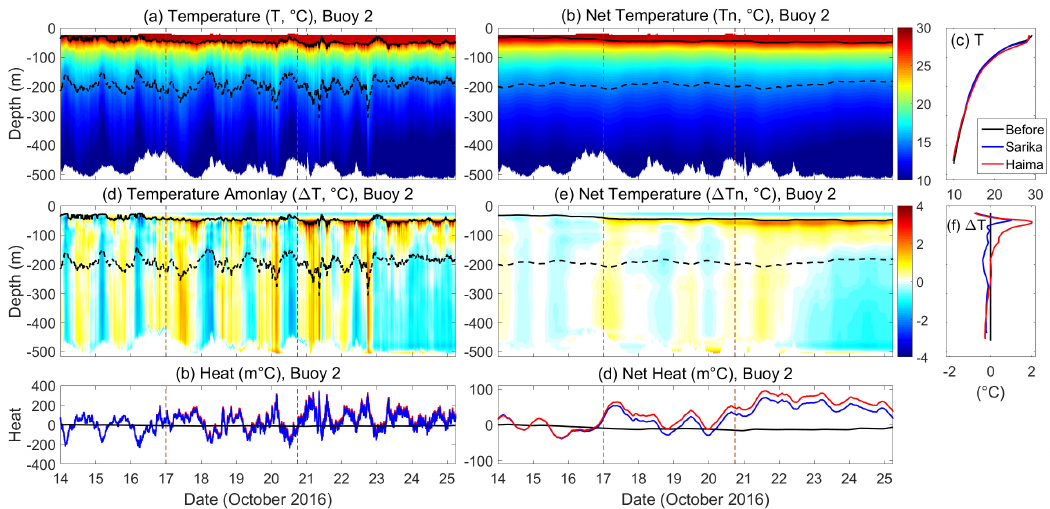
Figure 9. Temperature ( a ), temperature anomaly ( d ) and their net values ( b , e ) during Sarika and Haima at Buoy 2. Average temperature ( c ) and temperature anomaly ( f ) profiles before the two typhoons (black; averaged between 14 and 16 October), after Sarika (blue; averaged over one inertial period after 18 October), and after Haima (red; averaged over one inertial period after 22 October). The black solid lines in ( a , b , d , e ) indicate the mixed layer depth, which is the depth at which the temperature is 0.5 ◦ C lower than the surface layer temperature. The black dashed lines indicate the 15 ◦ C isotherm. ( g , h ) Accumulated surface heat flux (black lines), heat anomaly from 0 to 160 m (red lines), and their sum (blue lines) at Buoy 2. The vertical brown dashed lines represent the times when Sarika and Haima were closest to Station 2. The temperature observed by the sensor near the surface (at a depth of 22 m) was used for the heat content calculations for shallower depths.